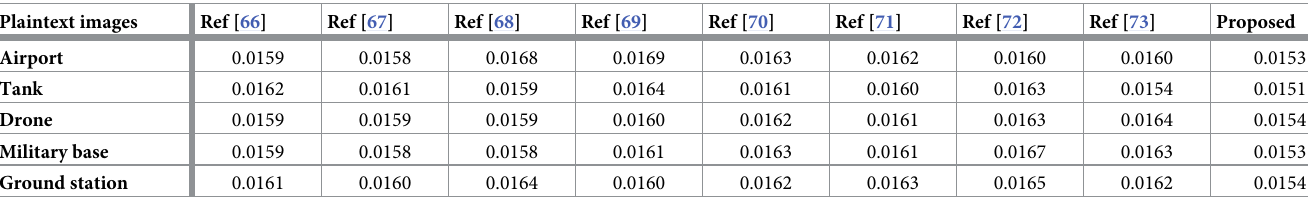
Table 10. Energy